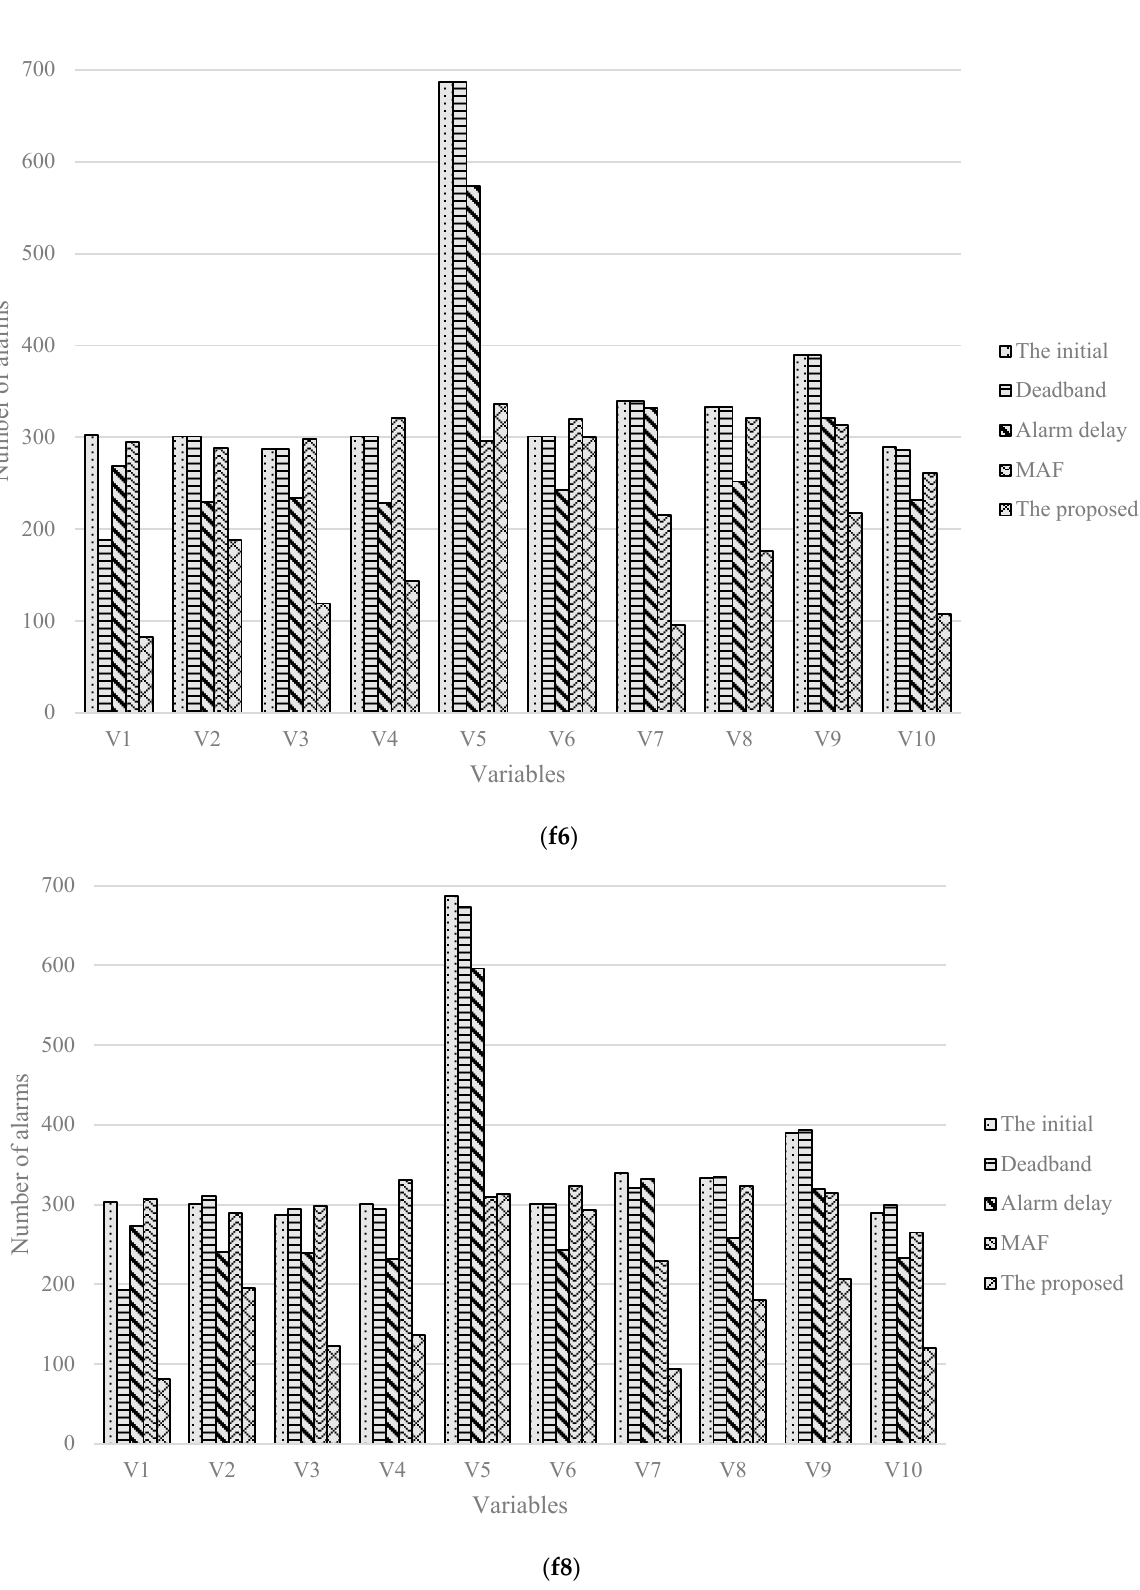
Figure 7. Histograms of FARs in five cases with two failures ( f6 , f8 ).